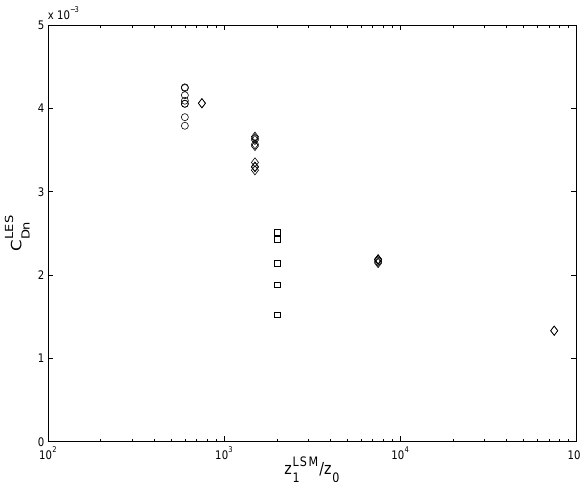
Fig. 5. The dependence of the normalized surface drag coefficient Fig. 4. The dependence of the surface drag coefficient for momen- C LES /C Dn on the PBL depth H . C Dn is the classical parameteri- Dn tum, C LES , on the internal dimensionless parameter z/z 0 . C LES is Dn Dn zation by Eq. (7). The solid line shows the ideal scaling. The dashed = 20 m (squares), calculated from the author’s LES database at z LSM line shows an empirical dependence by Eq. (13). Crosses and error- 1 = 60 m (circles) and z LSM = 150 m (diamonds). z LSM bars represent atmospheric data for C atm 1 1 al. (2004), where H has been recalculated according to Eq. (10) in the present study from Eq. (17) in Lange et al. work. Other symbols are the same as in Fig.